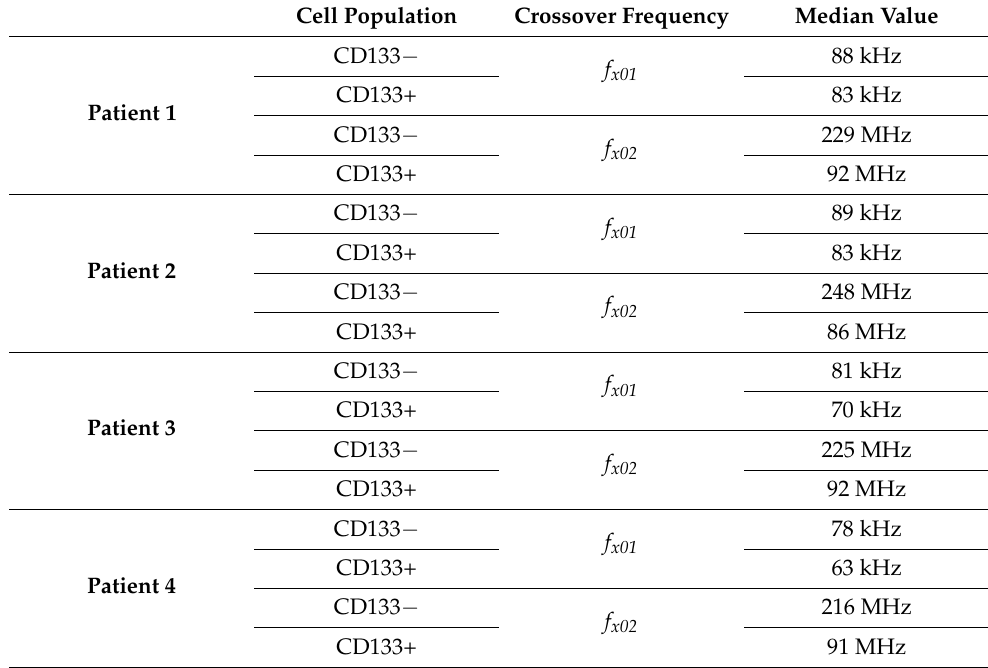
Table 4. Values of the crossover frequency measurements of the GBM primary culture extracted from tumor samples of four different